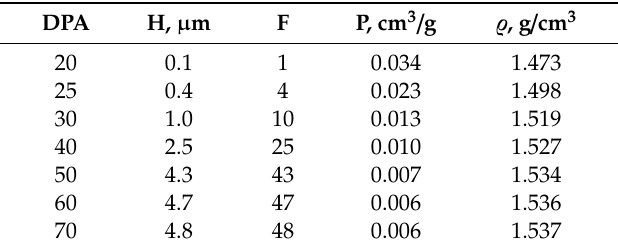
Table 1. Characteristics of cotton fibers of various age.